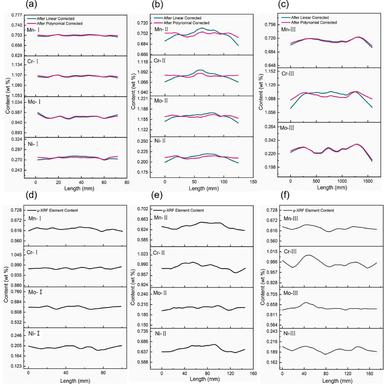
Three types of line distribution in the cross-section A11 (a) Line distribution of type I by the SMALS (b) Line distribution of type II by the SMALS (c) Line distribution of type III by the SMALS (d) Line distribution of type I by the μ-XRF (e) Line distribution of type II by the μ-XRF (f) Line distribution of type III by the μ-XRF.